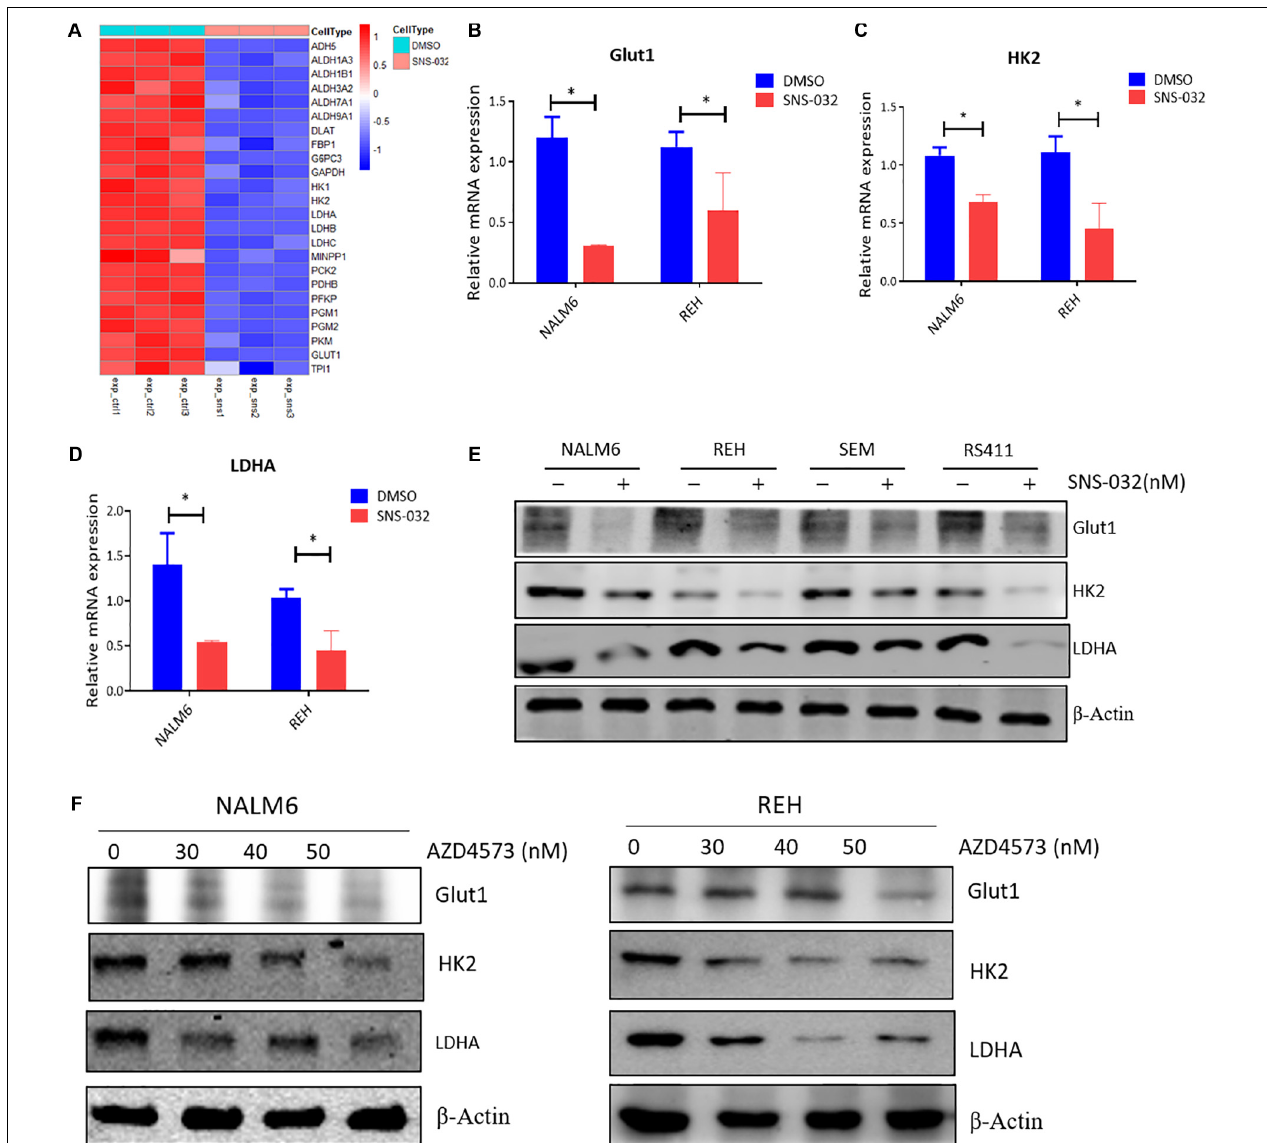
FIGURE 5 | CDK9i treatment alters the expression of metabolic enzymes in B-ALL cells. (A) Heatmap of glycolysis-related genes in REH cells analyzed by RNA-seq. (B–D) Relative mRNA expression levels of GLUT1, HK2, and LDHA measured by qRT-PCR in NALM6 and REH cells after treatment with SNS-032 for 24 h. (E) Protein expression levels of GLUT1, HK2, and LDHA in B-ALL cells detected by Western blot analysis after treatment with SNS-032 for 24 h. (F) Protein expression levels of GLUT1, HK2, and LDHA in NALM6 and REH cells detected by Western blot after treatment with AZD4573 for 24 h. Values were shown as mean ± SEM. ∗ p <